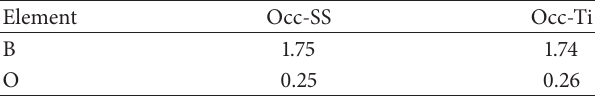
Table 1: Oxygen occupancy on HT